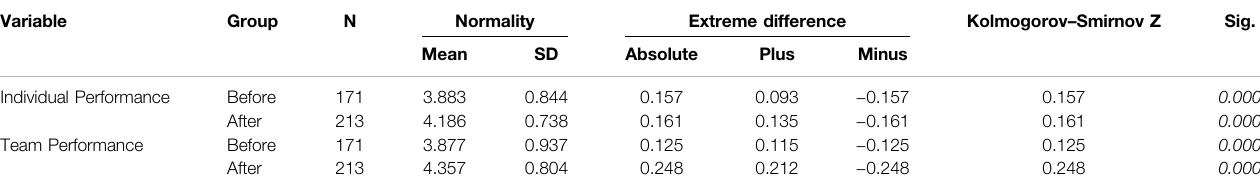
TABLE 2 | Normality test of data.